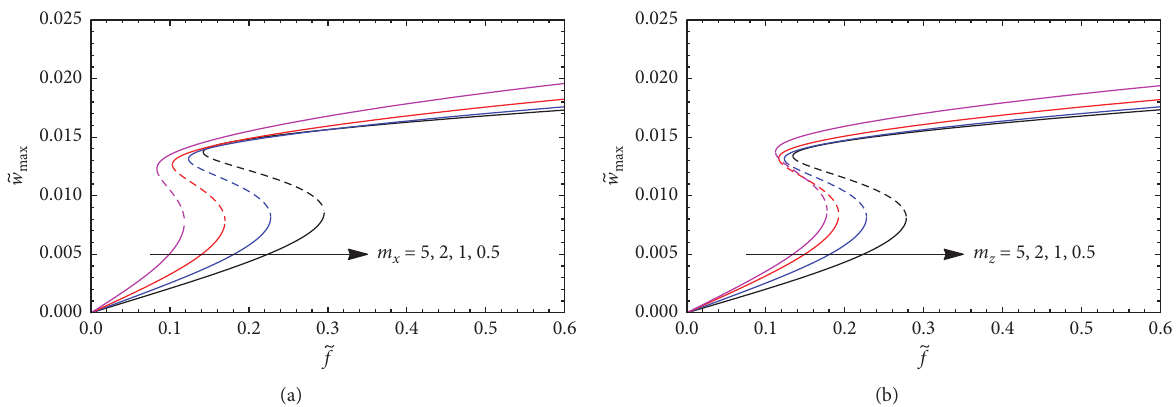
Figure 9: Effect of the material gradient parameters m � 0 . 1, L / h � 20, 􏽥 c when α 0